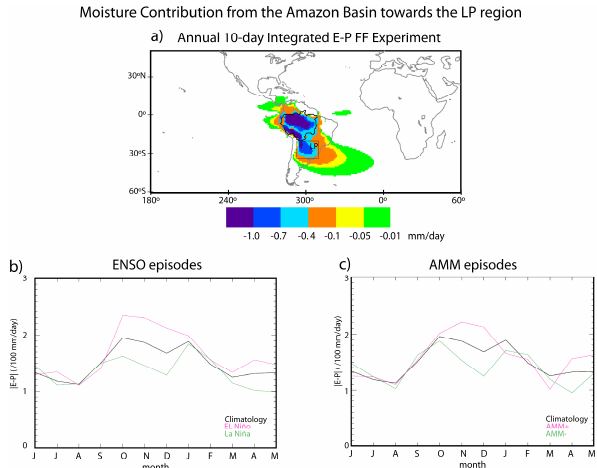
Figure 4. (a) Climatological annual average of 10-day integrated ( E − P ) obtained through the forward Amazon experiment for the period June 1979–May 2012. Black contour line indicates the basin area, and the LP box indicates the sink area selected. (b) The annual cycle of the monthly absolute values of 10-day ( E − P ) shown in Fig. 3 and integrated over the LP sink area indicated in (a) . Black lines represent the 33-year average values, while pink and green lines indicate the average of the El Niño and La Niña, respectively. (c) : as (b) , but the pink and green lines indicate the average of the AMM + and AMM − events,